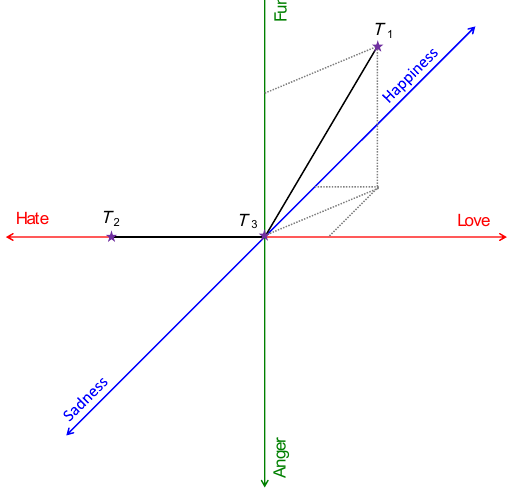
Fig. 3 Representation of the sentiment space.